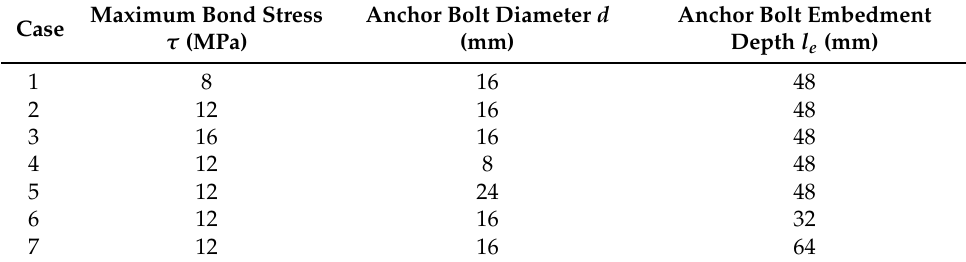
Table 4. Analysis